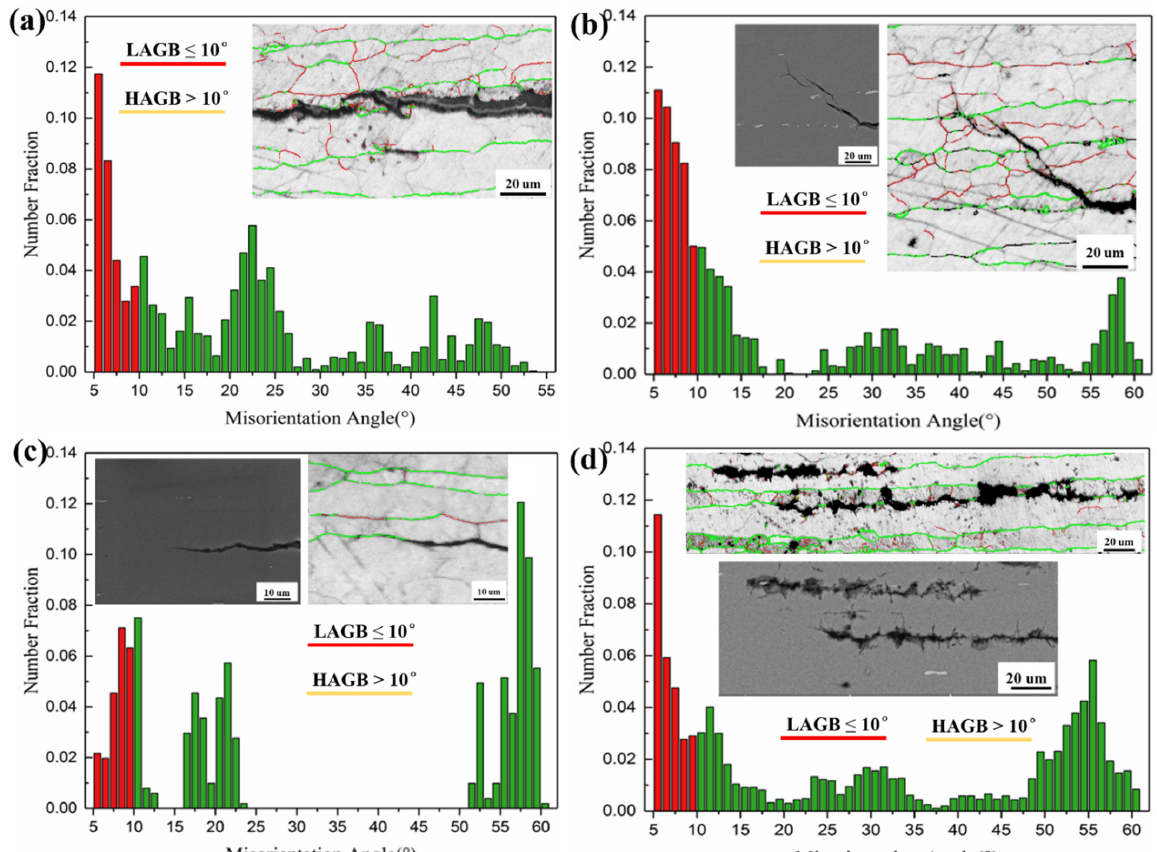
Figure 9. The statistics of high ‐ angle grain boundaries (HAGBs) and low ‐ angle grain boundaries (LAGBs) for the selected regions of the DCB specimen: ( a ) GB analysis along the crack growth path; ( b ) GB analysis of IGSCC; ( c ) GB analysis at a crack tip; ( d ) GB analysis of multiple cracks inside the DCB specimen.